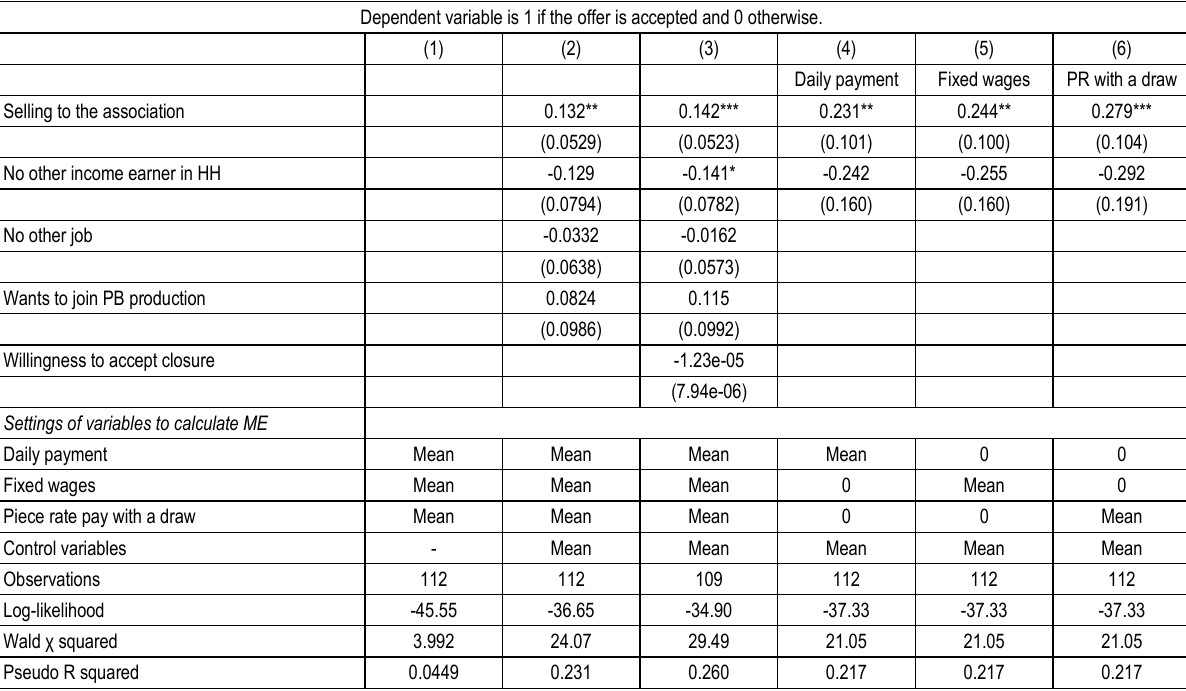
Table 3 (cont.) Accepting a job offer: marginal effects (logit estimations) Dependent variable is 1 if the offer is accepted and 0